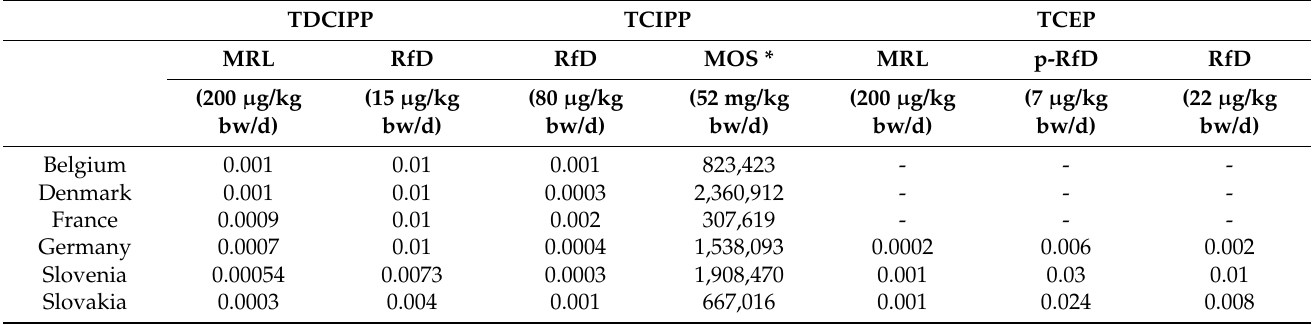
Figure 2. The contribution of the dietary exposure to the estimated daily intake in µg/kg bw/d. marked as * means the dietary intake exceeded the estimated daily intake, therefore, only the dietary intake is shown. Table 4. Risk Characterisation Ratio (RCR) of the used HBM data (P95) with the different HBGVs and the estimation of the Margin of